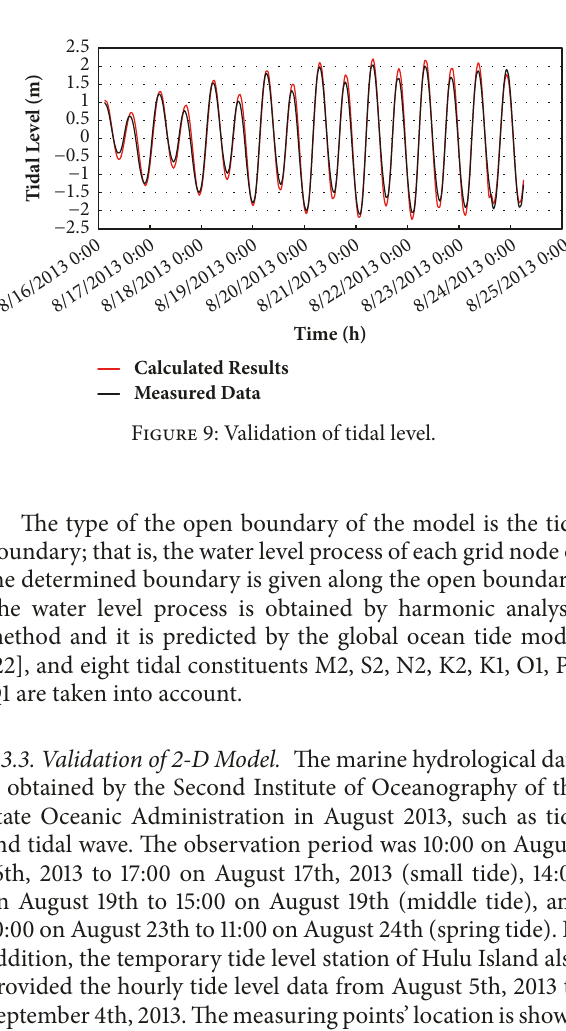
Figure 8: Submarine elevation contour.